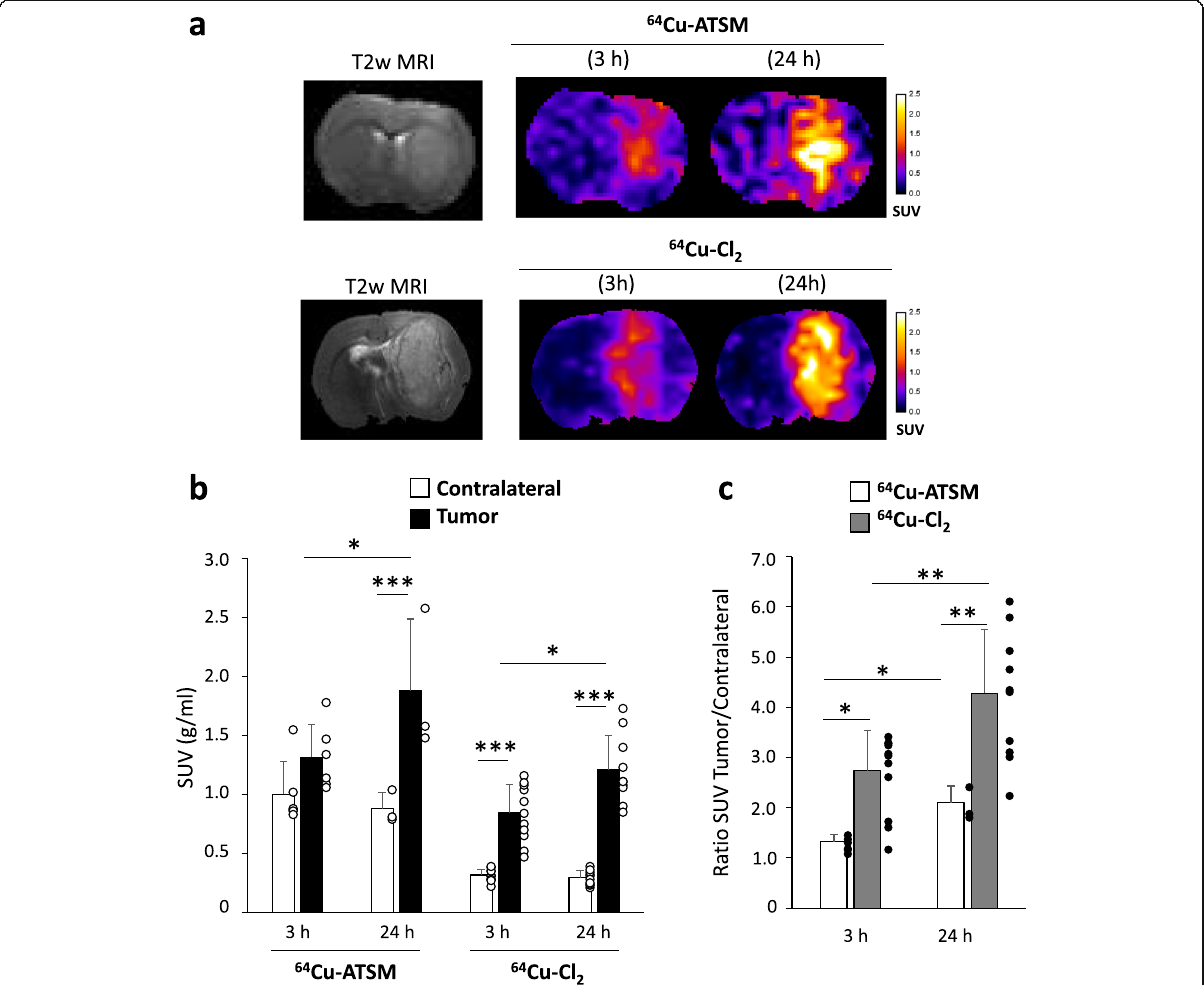
Fig. 1 In vivo uptake of 64 Cu-ATSM and 64 Cu-Cl 2 in C6 glioblastoma model. a MRI and PET images were acquired 15 days after tumor cell implantation into the striatum. 64 Cu-ATSM and 64 Cu-Cl 2 uptake were evaluated at early (3 h) and late (24 h) times after radiotracer injection. Quantification of 64 Cu-ATSM and 64 Cu-Cl 2 uptake from ipsilateral (tumor) and contralateral (healthy brain) SUVs ( b ) or ratio between tumor and contralateral SUVs ( c ) at the different imaging points. Mean ± SD, n = 6 rats for 64 Cu-ATSM and n = 11 rats for 64 Cu-Cl 2 . Tukey ’ s HSD test after significant two-ways ANOVA (group and time factors): * p < 0.05, ** p < 0.01, and *** p <